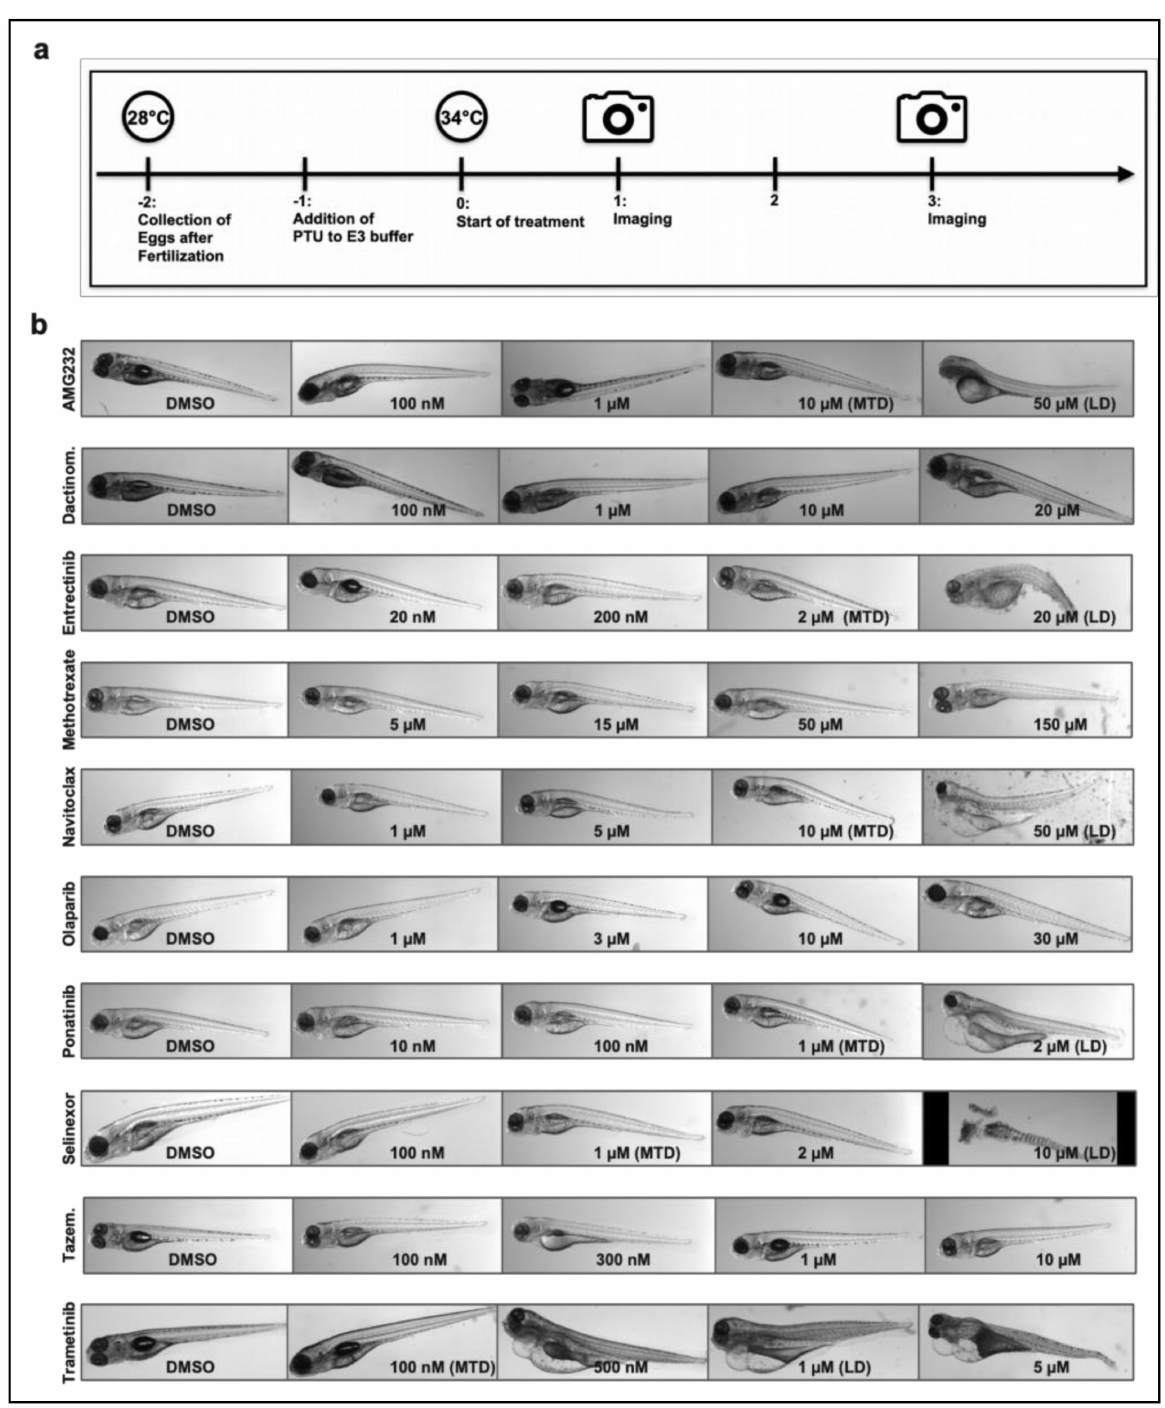
Figure 3. Zebrafish embryo drug toxicity test with selected validation candidates. ( a ) Timeline. Zebrafish embryo started receiving treatment on experimental day 0 (48 hpf) and embryos ( n = 3 per concentration) were imaged on experimental day one and day three. ( b ) Representative images of embryos treated with drug hits of interest for subsequent validation